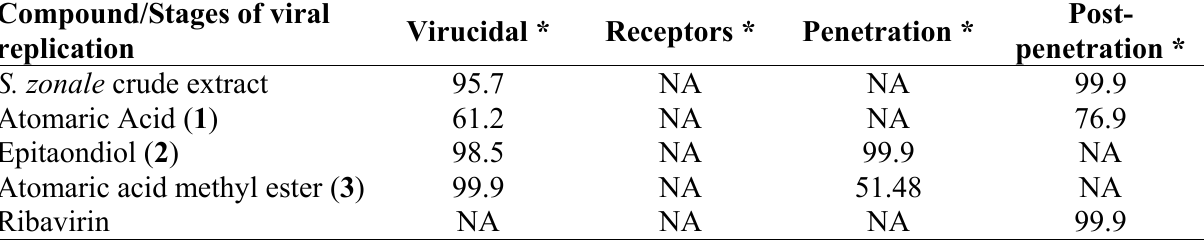
Table 2. Mechanism of action of the compounds.